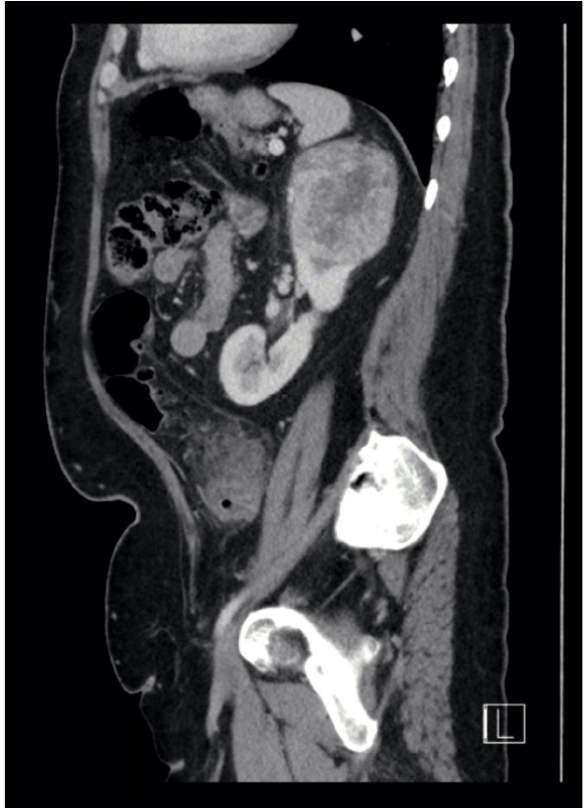
Figure 1: Sagittal CT view showing upper pole right renal